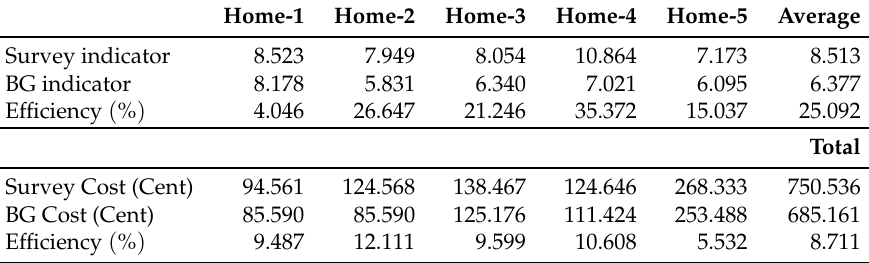
Table 9. Comparison of survey and Bayesian Game results.